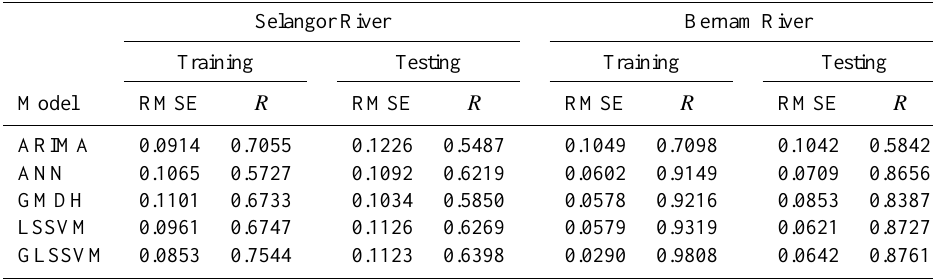
Table 6. Forecasting performance indices of models for Selangor and Bernam